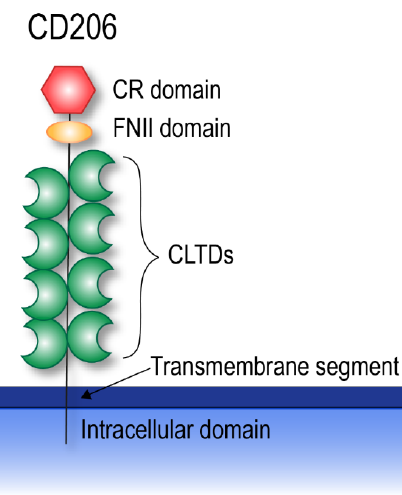
Figure 3. CD206 structure. CD206 is composed of an intracellular domain, a single transmembrane segment, and an extracellular domain. The extracellular domain is comprised of an N-terminal CR domain, a FNIII domain, and eight CTLDs. CR, cysteine rich; FNII, fibronectin type II; CTLD, C-type lectin domain.